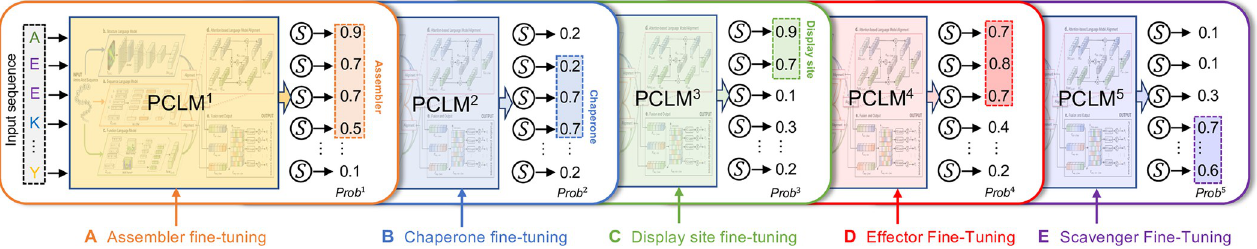
Fig 2. The functional specific fine-tuning of protein cubic language model (PCLM). The pretrained PCLM model was separately fine-tuned with five categories of disordered molecular functions into five corresponding PCLM 1-5 models for predicting assembler ( A ) chaperone ( B ) display site ( C ) effector ( D ) and scavenger ( E ) functional residues from the input sequence. Prob 1 , Prob 2 , Prob 3 , Prob 4 , and Prob 5 represent the predicted propensity scores for the five functions of input sequence,